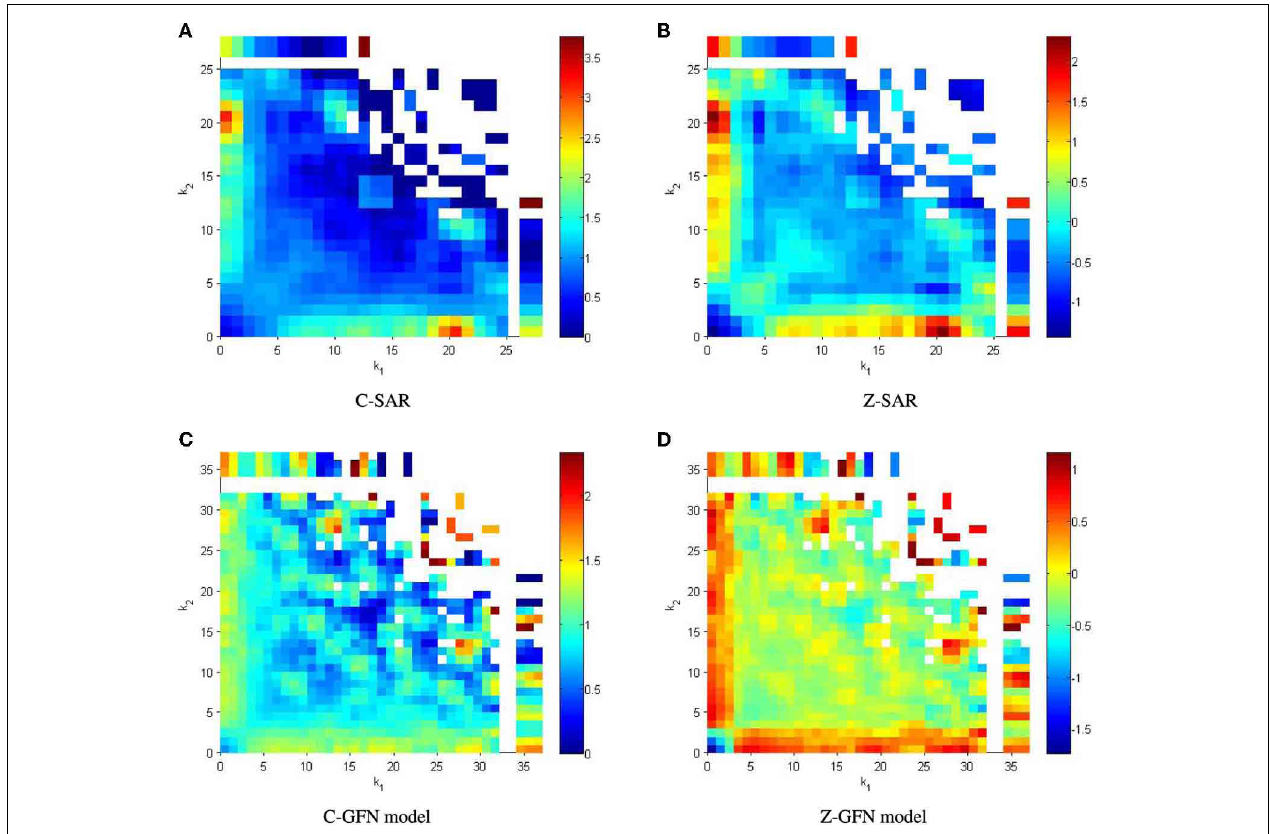
16 SAR images from the Kara sea. (C,D) Average for 20 samples of the Growing Fracture Network model, with parameters N = 300 and p = 0 . 1, run for1000timesteps. (A) C-SAR, (B) Z-SAR, (C) C-GFNmodel, (D)